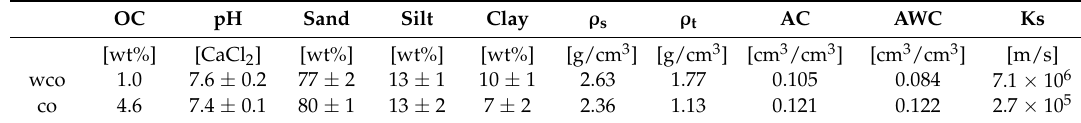
Table 10. Soil characteristics of boulder marl without compost (wco) and with compost (co), with 4 replicate measurements for organic carbon (OC), pH value, texture, particle density ( ρ s ), respectively. Dry bulk density ( ρ t ), air capacity (AC), the plant available water capacity (AWC), and saturated hydraulic conductivity (Ks) with 10 to 15 soil cores, respectively. The symbol ± indicates the standard deviation.